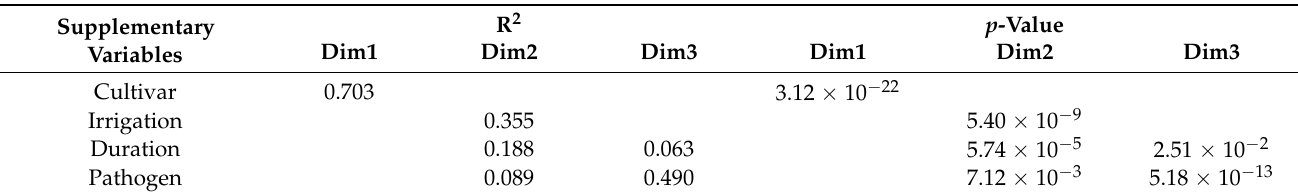
Table 2. Significant square correlation ratios (R 2 ) of the supplementary variables in the principal component analysis (PCA). R 2 indicates the strength of the correlation between the dimensions of the PCA and the variables cultivar (Chardonnay or Xynisteri), irrigation (full or deficit), duration (of the irrigation treatment; 9 or 16 dot), and pathogen ( P. viticola or water inoculation). These supplementary variables were not involved in the construction of the dimensions. For each significant R 2 , the p -value is also shown.